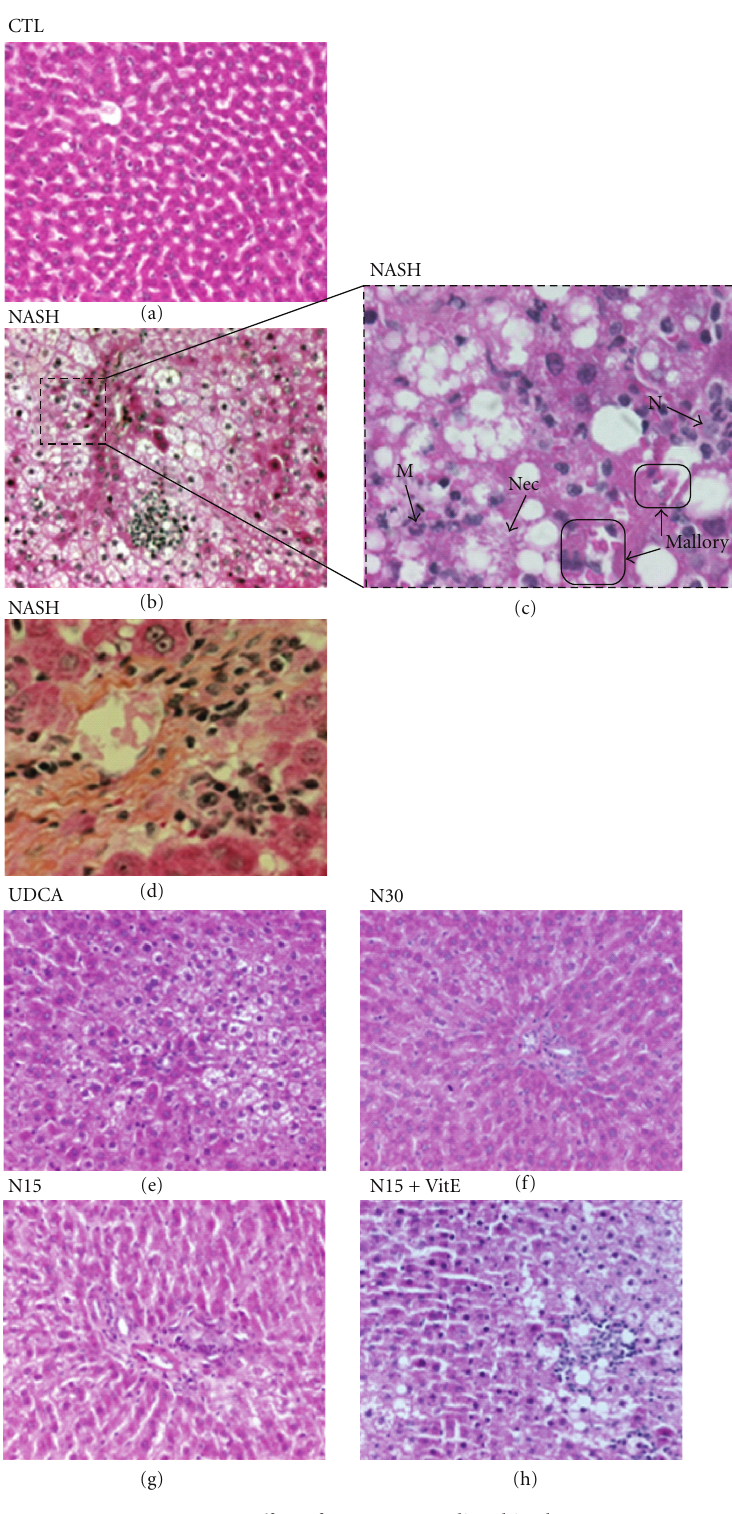
Figure 2: E ff ect of treatments on liver